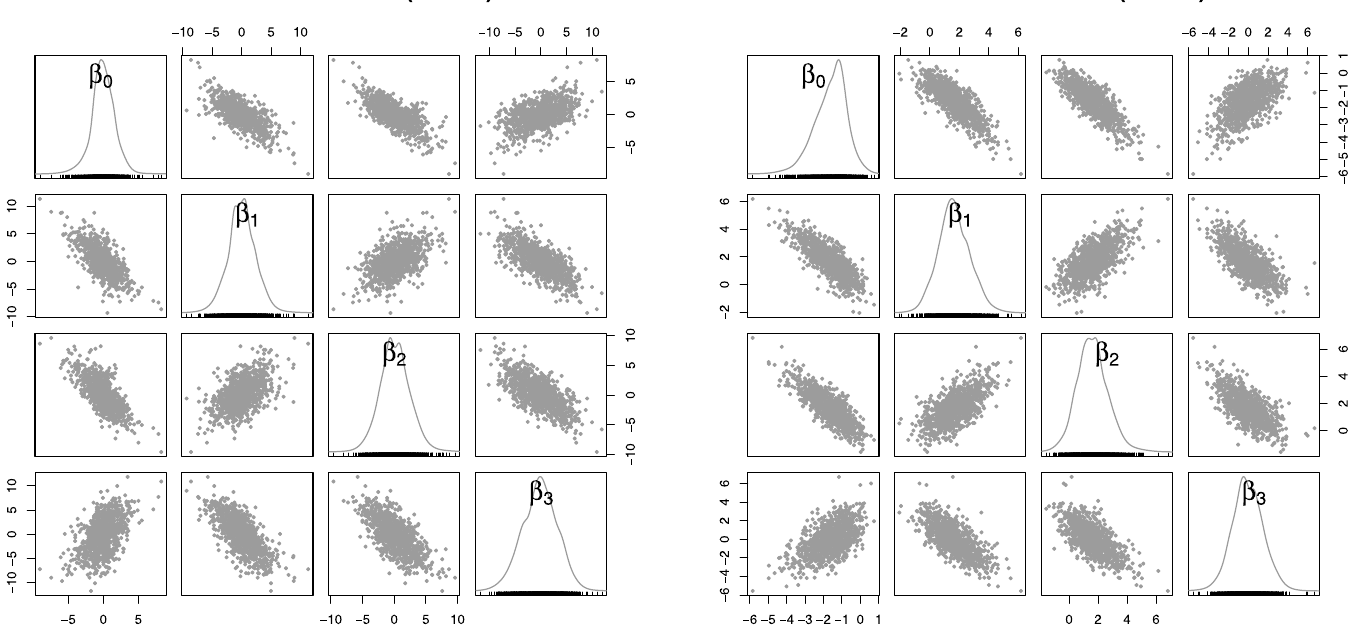
Fig 6. Joint prior distributions of model parameters. The scatter plots graphically demonstrate the joint prior distribution of ~ b ¼ ð b independent beta priors on π (0,0) , π (1,0) , π (0,1) , and π (1,1) . The figure on the left demonstrates prior 1 (non-informative prior), and the figure on the right demonstrates prior 2 (informative prior).